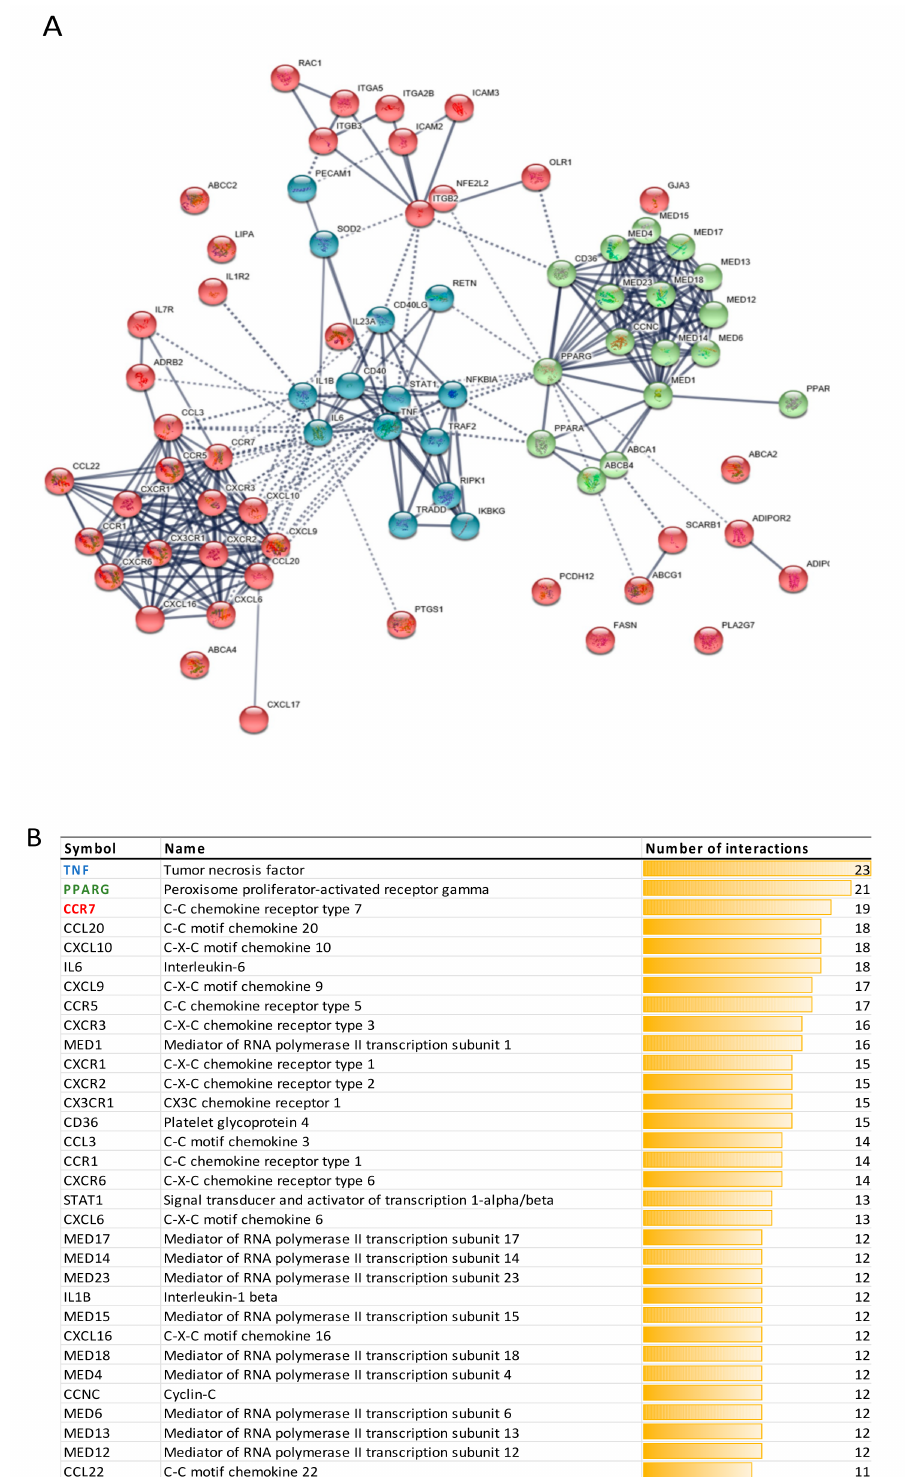
Figure 4. ( A ) Protein-protein interactions for proteins encoded by the extracted genes, as well as several neighboring proteins (up to 10 interactions within the first shell; up to 5 interactions within the second shell), organized in 3 clusters. ( B ) Proteins that have more than 10 interactions within the protein-protein interactions network. Top 3 proteins belong to a different cluster